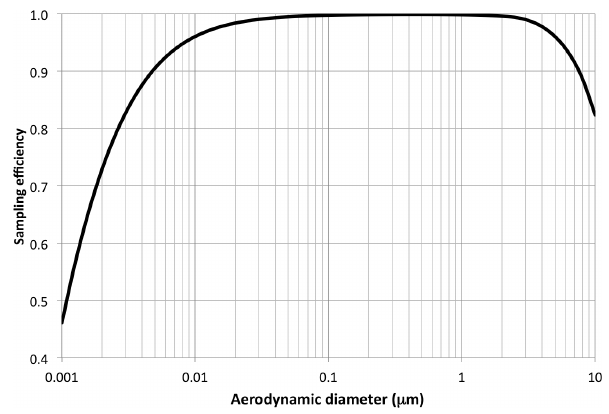
Figure 2. Calculated sampling efficiency of particles reaching the CLAP